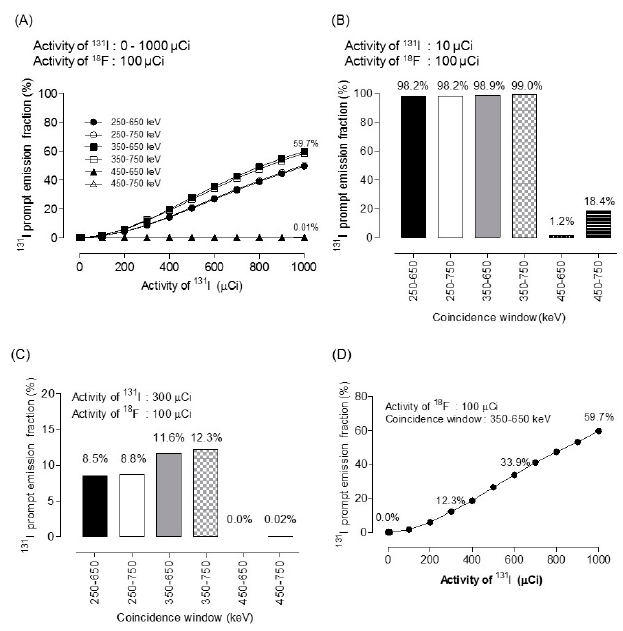
Figure 4. 131 I prompt emission fraction within various energy windows. ( A ) Activity of 131 I was set to 0 to 1000 µ Ci in steps of 100 µ Ci with 100 µ Ci 18 F activity. ( B ) 10 µ Ci of 131 I with 100 µ Ci of 18 F. ( C ) 300 µ Ci of 131 I with 100 µ Ci of 18 F ( D ) 131 I prompt emission fraction within 350–650 keV at the level of 100 µ Ci of 18 F.